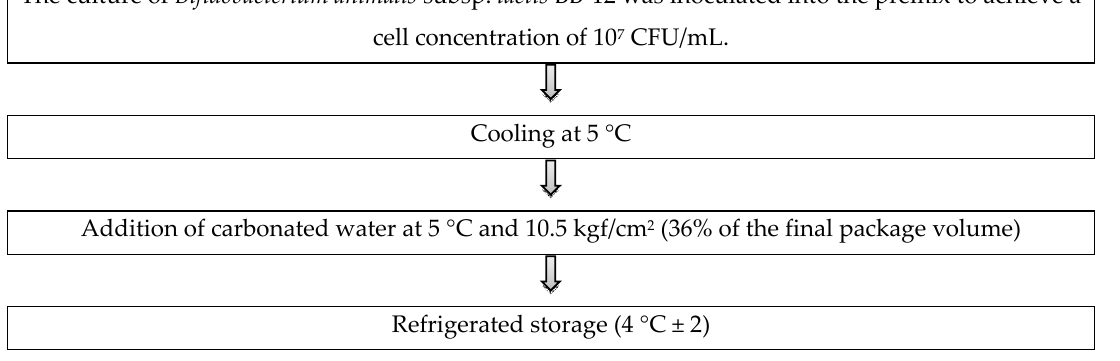
Figure 1. Manufacture of the probiotic functional carbonated beverage. * The amount of whey and the other constituents of the beverage were calculated as a % w / w of premix.